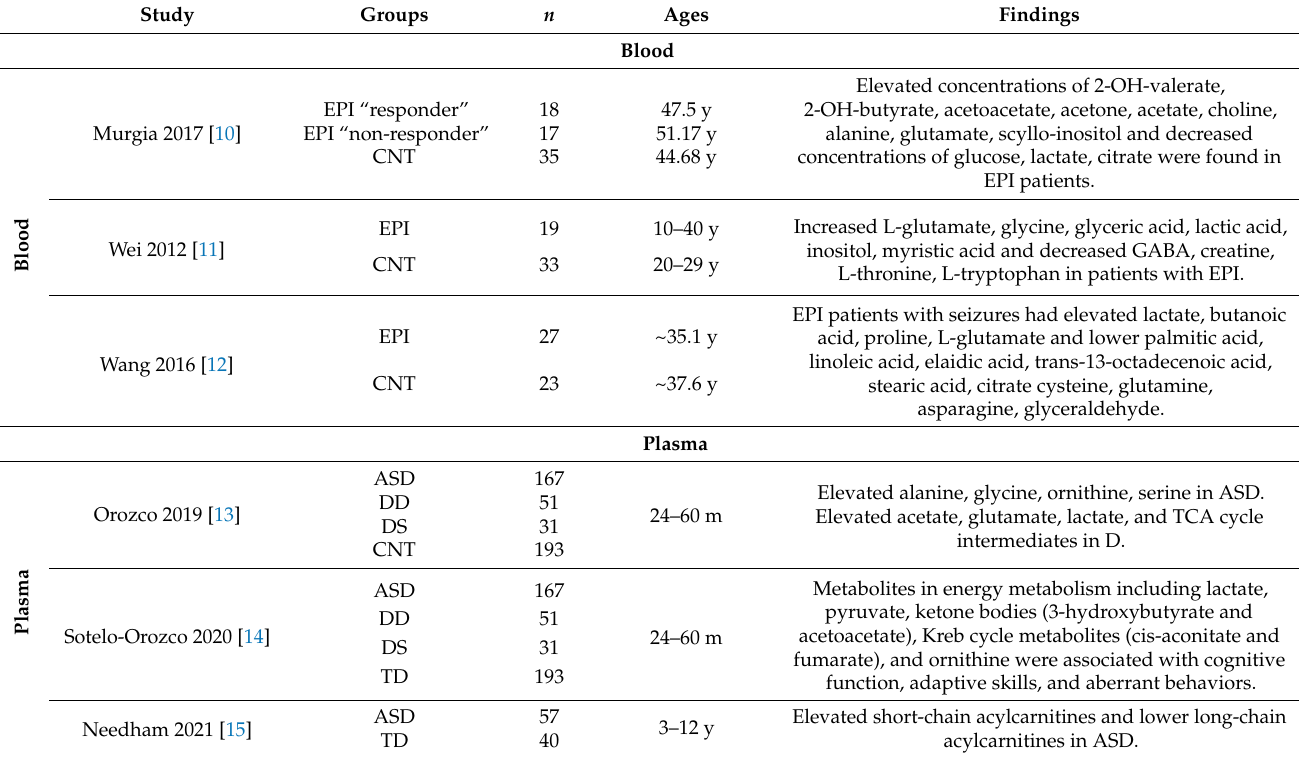
Table 1. Previous metabolomics studies on neurologic and neurodevelopmental